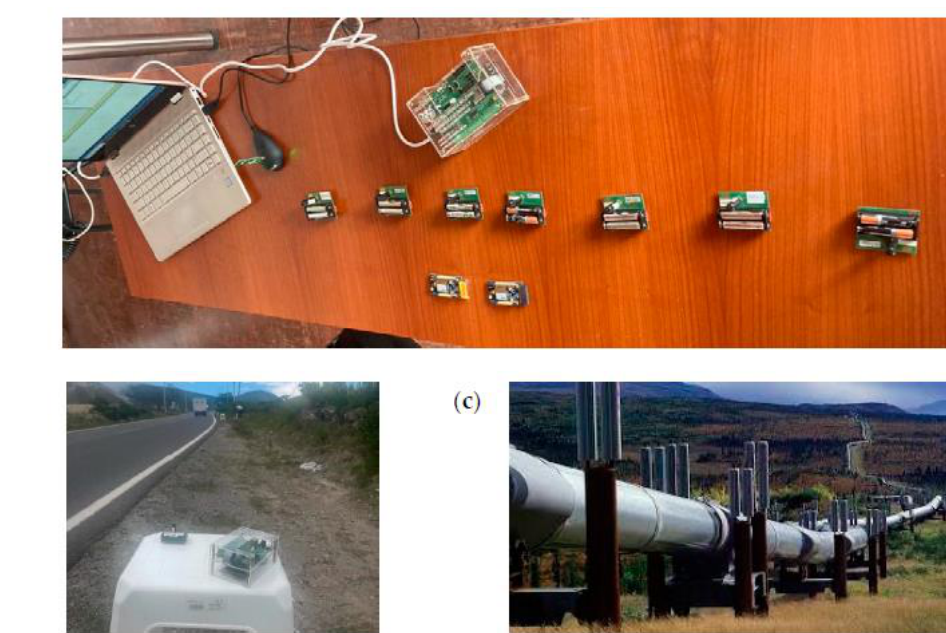
Figure 18. ( a ) Used hardware. ( b ) Scenario for the tests. ( c ) Typical pipeline implementation.